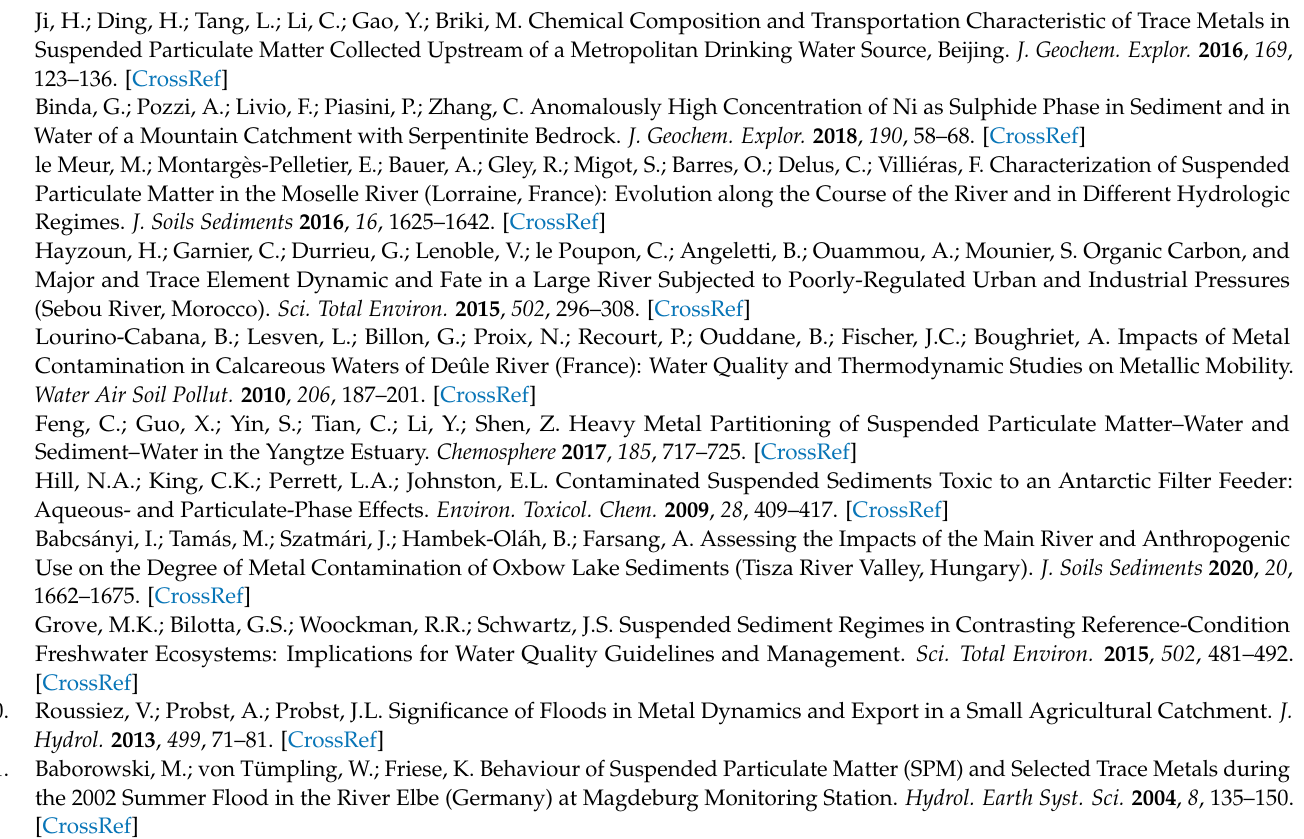
Figure S1. Amount of SPM versus discharge at Sremska Mitrovica, Serbia (70 km upstream Belgrade sampling